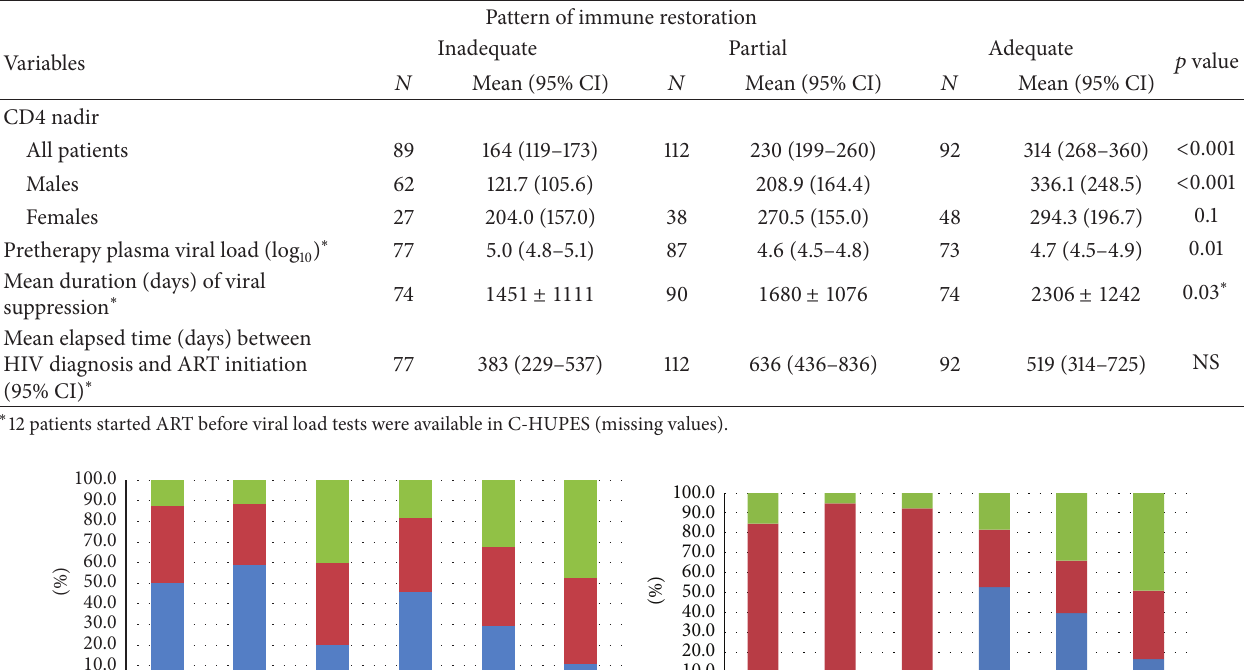
Table 3: Mean HIV-1 RNA plasma viral load and and CD4 count of patients at baseline, according to immune restoration pattern.